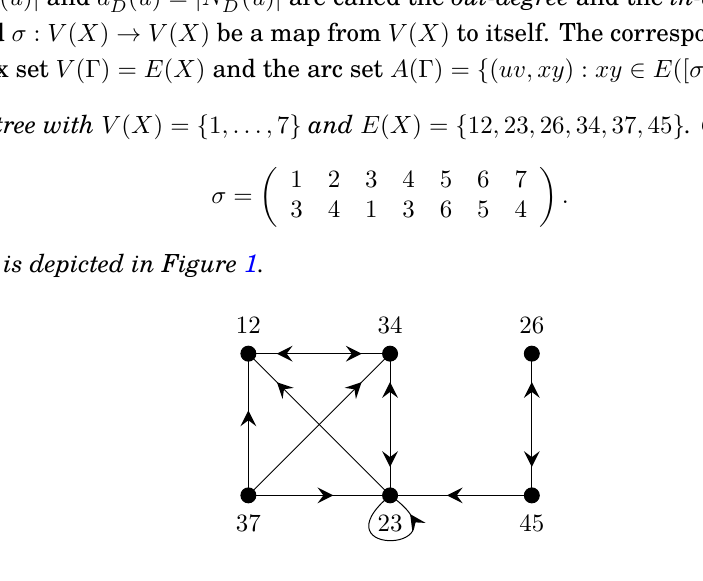
Figure 1: The Markov graph Γ( X, σ ) for the pair ( X, σ ) from Example